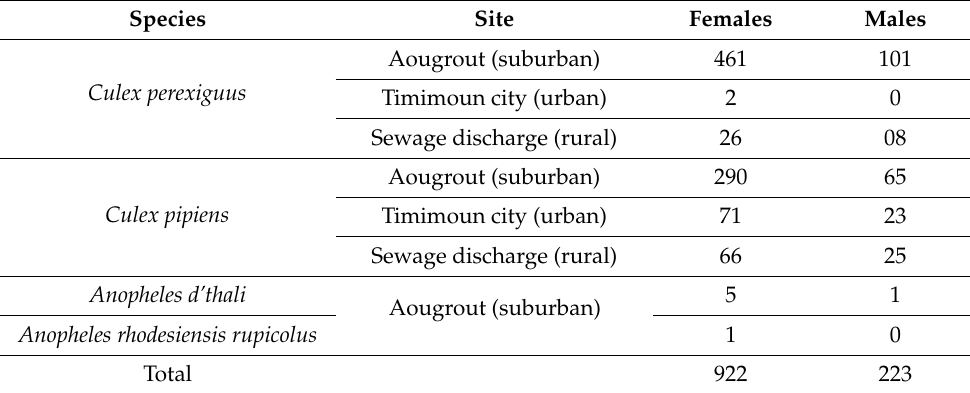
Table 1. Mosquito species identification by site of